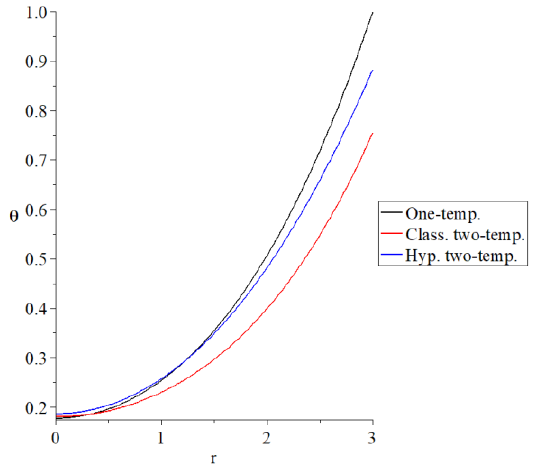
Figure 3. The distribution of the dynamic temperature increment for the variance values of the two-temperature parameter when D = 0.2.